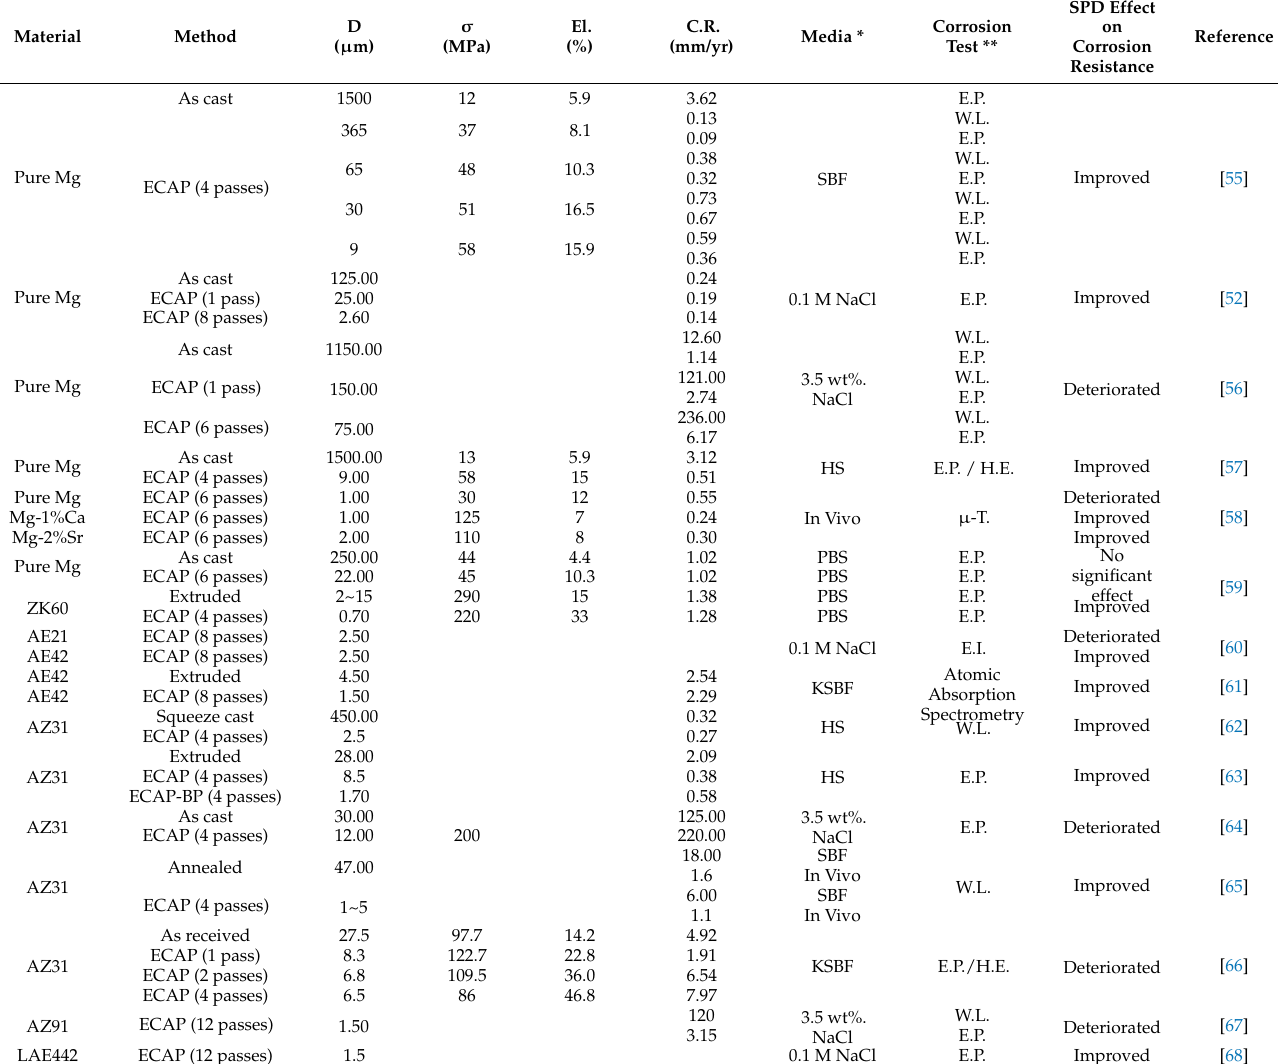
Table 1. Summary of magnesium alloys, SPD processing method, grain size (d), flow stress ( σ ), elongation to failure (El.), corrosion rate (C.R.), corrosion media, corrosion tests and reported SPD effect on corrosion